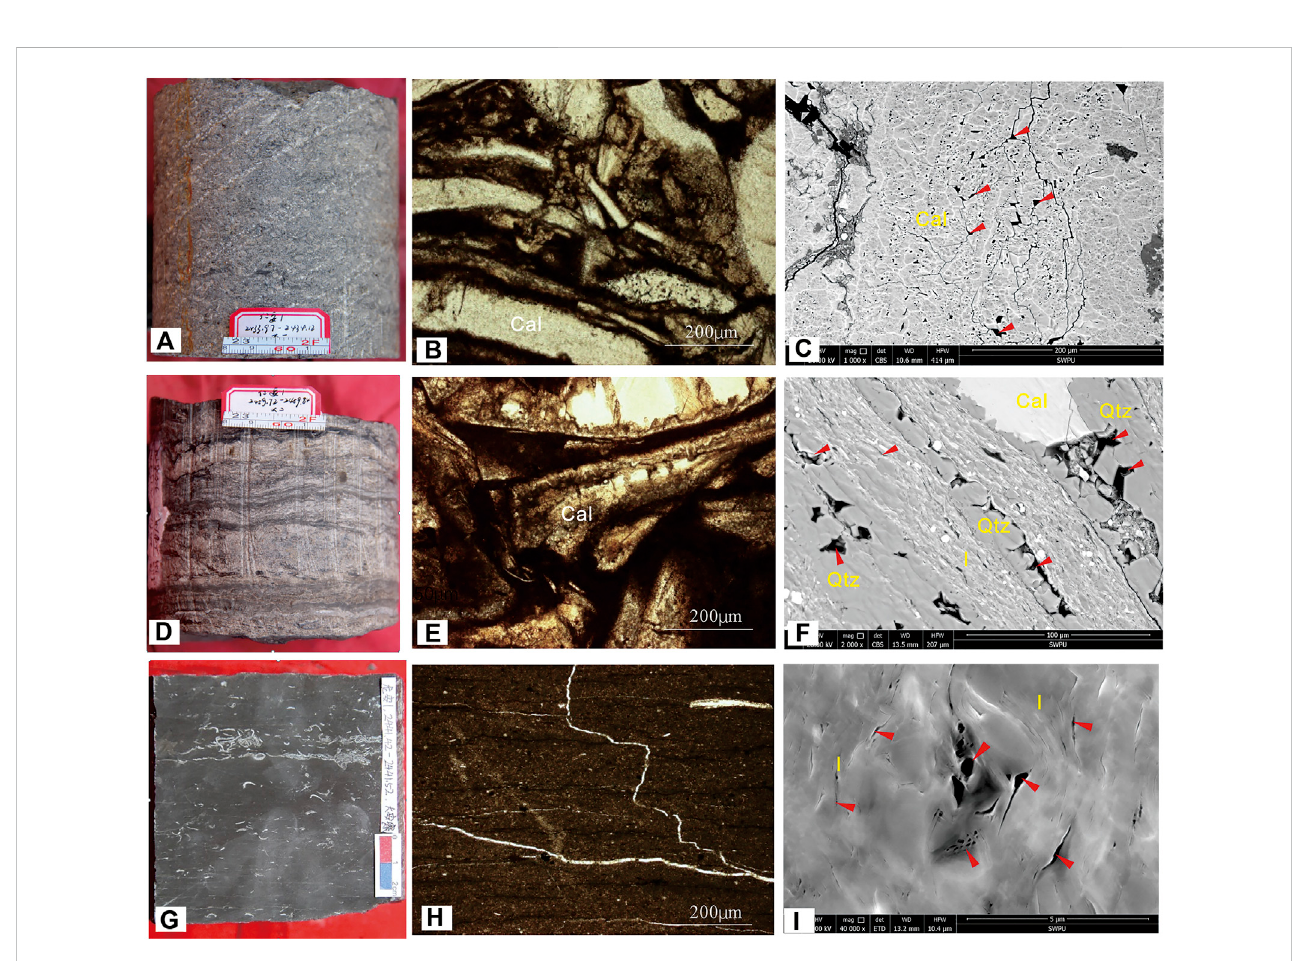
Core photographs of typical lithofacies and corresponding thin section microscopic image as well as pore characteristics under SEM of Well RA1. (A) massive mud-bearing shell limestone, 2,433.97 – 2,433.12 m; (B) microscopic photos of massive mud-bearing shell limestone, 2,433.97 – 2,433.12 m; (C) intercrystalline pores of shell calcite (Cal), 2,433.97 – 2,433.12 m; (D) medium-thick argillaceous shell limestone, 2,459.72 – 2,458.80 m; (E) microscopic photos of medium-thick argillaceous shell limestone, 2,459.72 – 2,458.80 m; (F) intercrystalline pores of quartz (Qtz) and clay minerals (I) , 2,459.72 – 2,458.80 m; (G) laminated shell-bearing shale, 2,441.42 – 2,441.52 m; (H) microscopic photos of laminated shell-bearing shale, 2,441.42 – 2,441.52 m; (I) intercrystalline pores of clay mineral (I) , 2,441.42 – 2,441.52